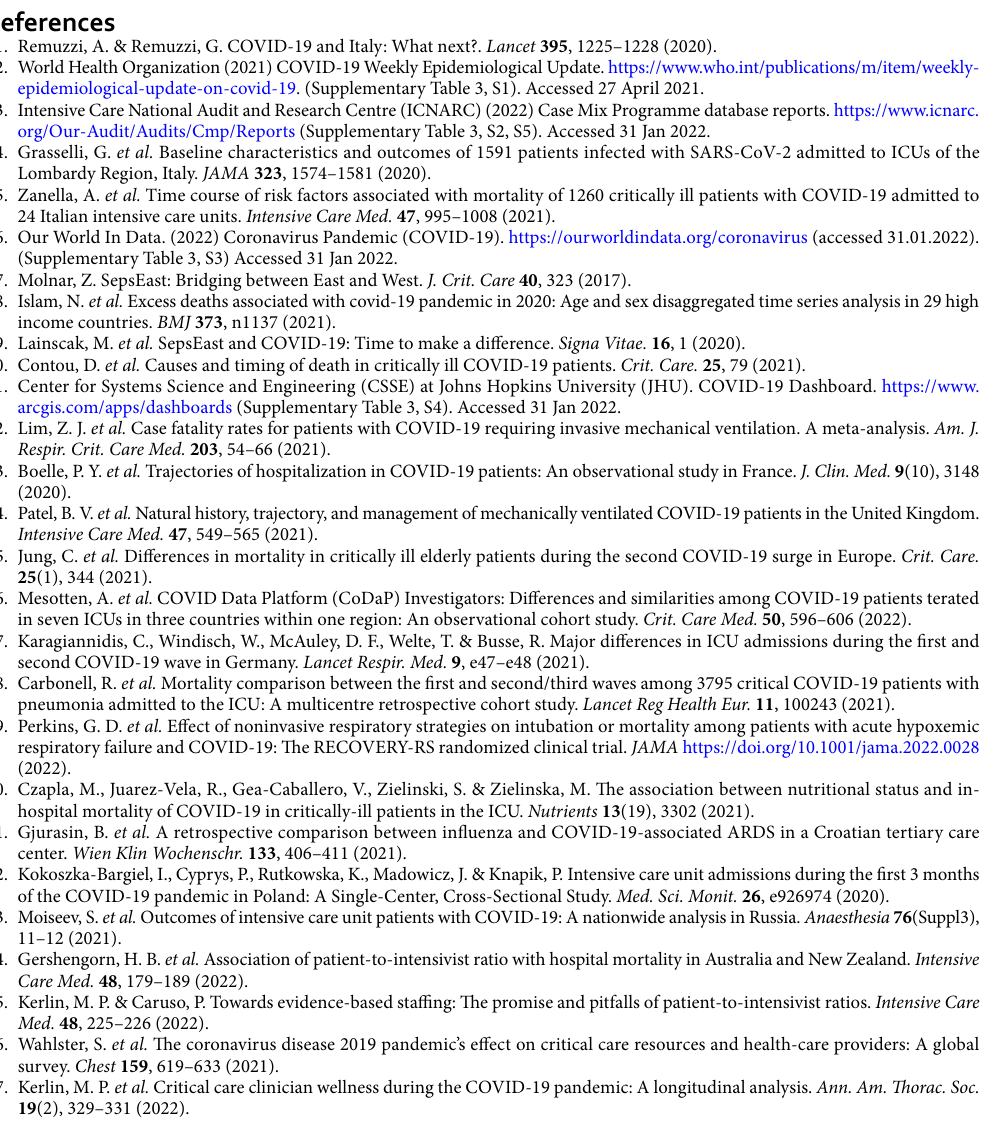
(Supplementary Table 3, S3) Accessed 31 Jan 2022. 7. Molnar, Z. SepsEast: Bridging between East and West. J. Crit. Care 40 , 323